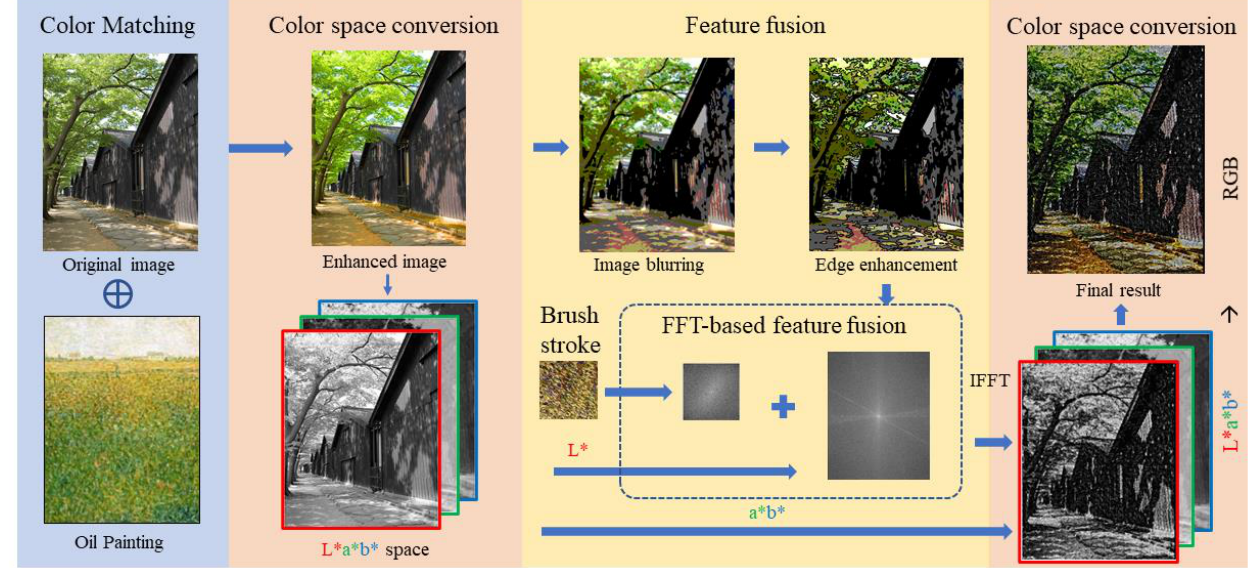
Figure 4. Process of producing oil painting-style images made by non-photorealistic rendering.